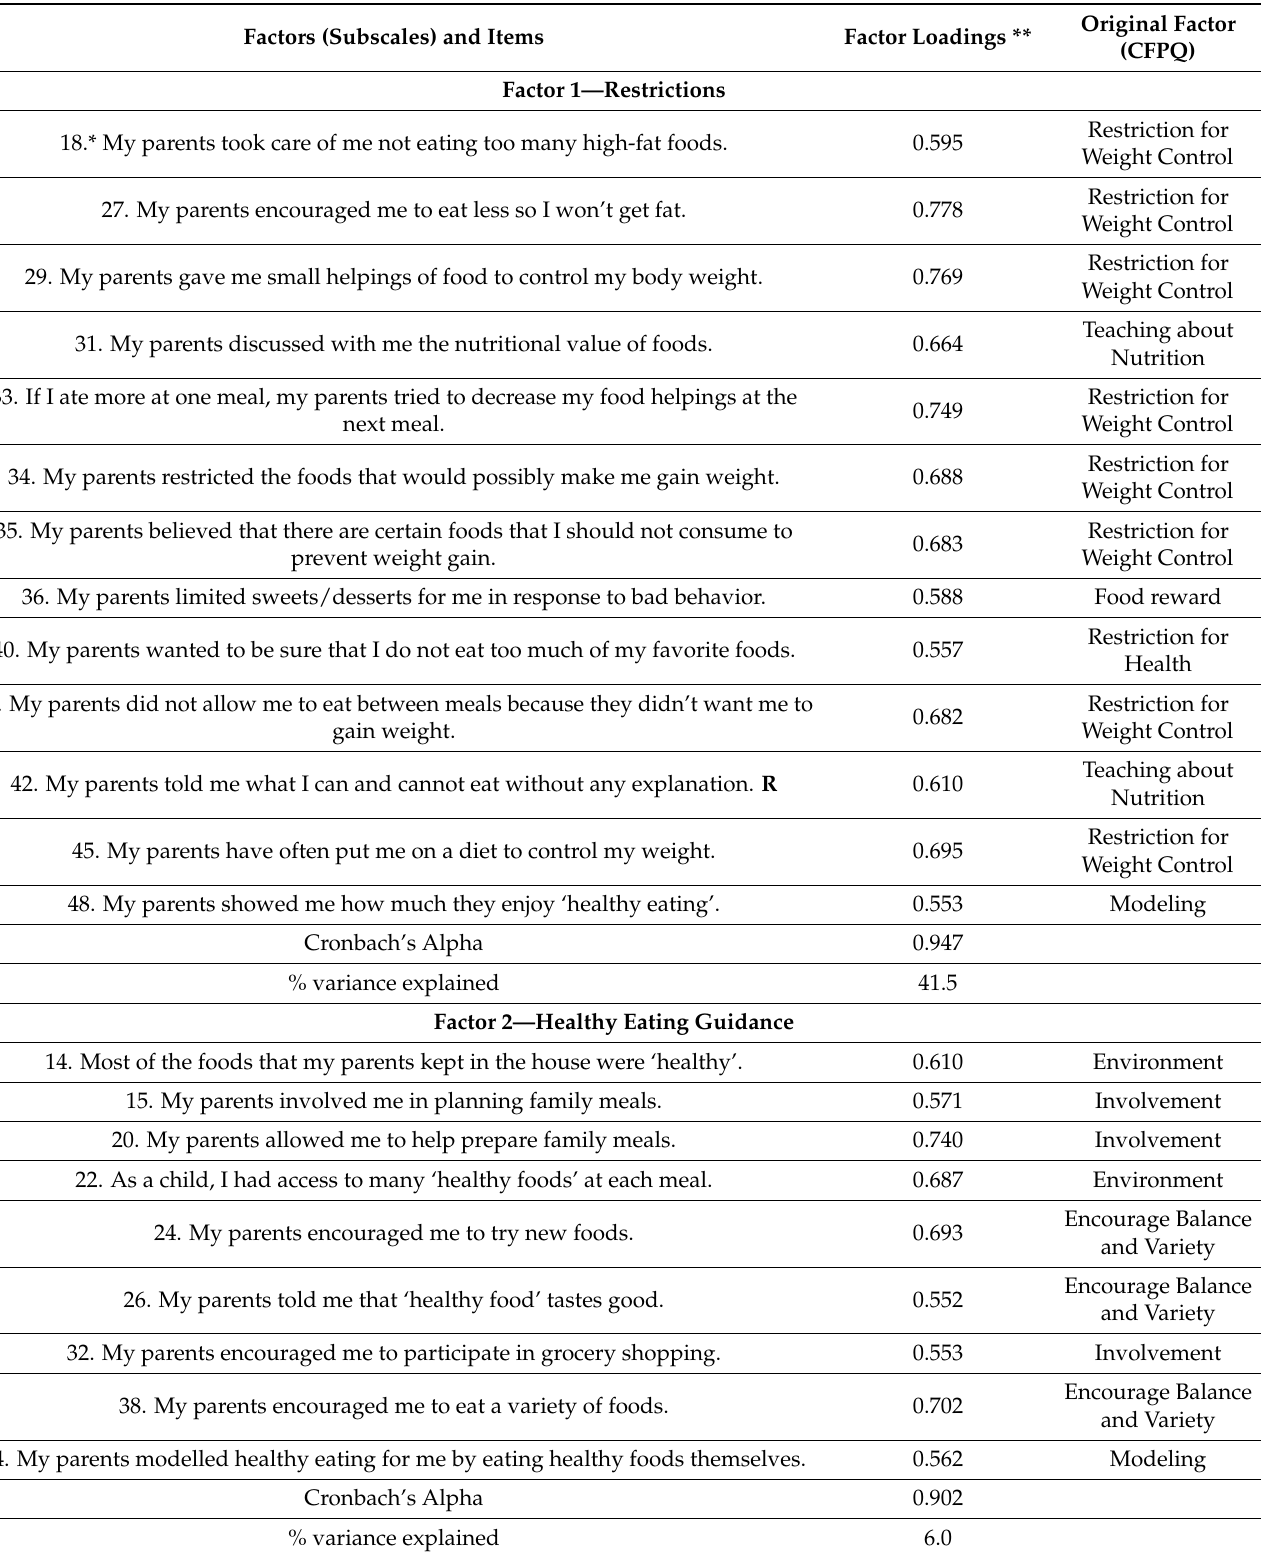
Table 2. Factors and items included in the modified Comprehensive Feeding Practices Questionnaire